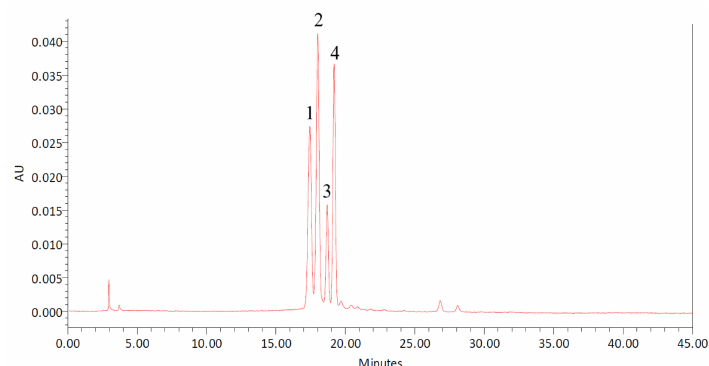
Figure 4. Typical HPLC chromatogram of DBP, showing the detected free anthocyanins at 520 nm. (1) Delphinidin-3- O -glucoside, (2) delphinidin-3- O -rutinoside, (3) cyanidin-3- O -glucoside, and (4) cyanidin-3- O